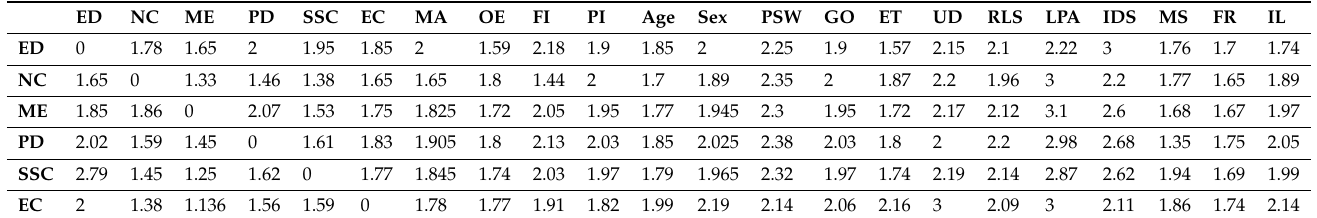
Table 2. Average